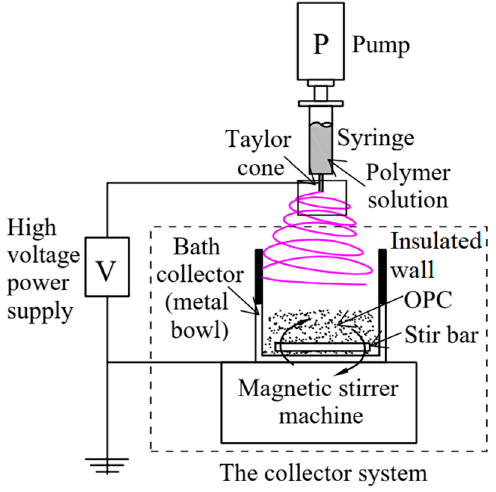
Figure 1. The setup of the electrospinning process. OPC: ordinary Portland cement.